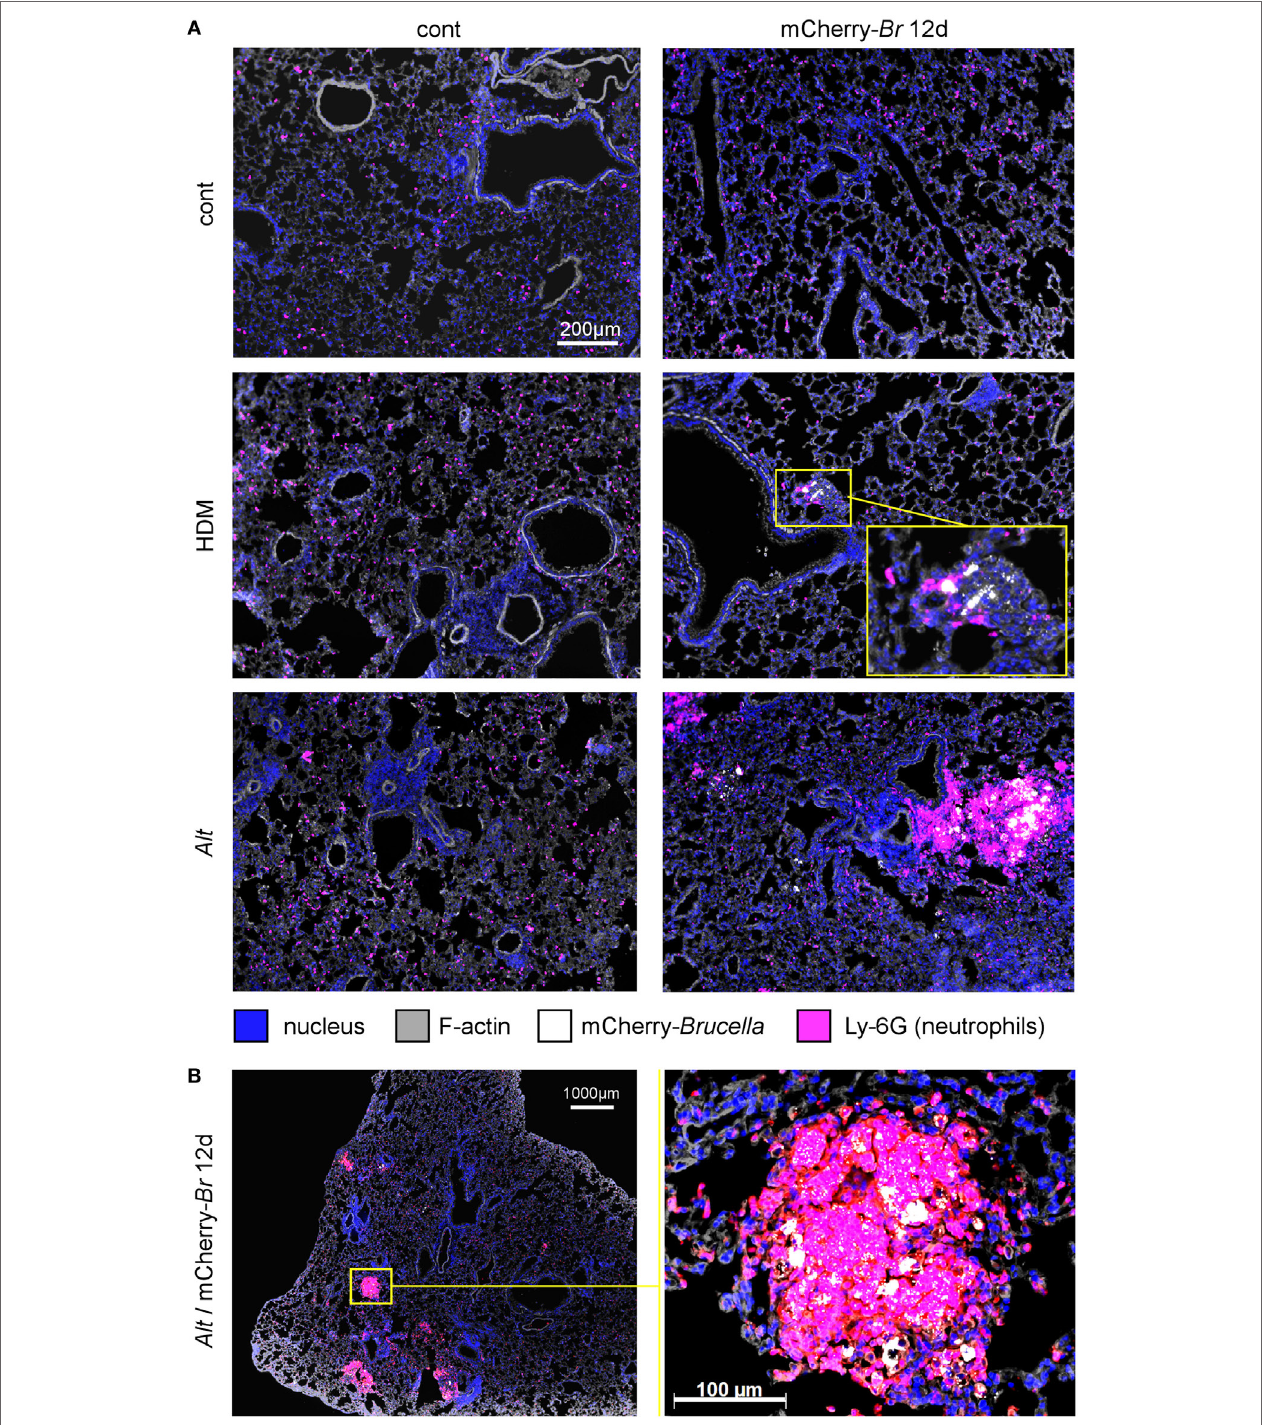
FigUre 2 | Microscopic analysis of lungs from control, HDM and Alt sensitized BALB/c mice. Wild-type BALB/c mice received repeated i.n. administration of phosphate-buffered saline (PBS) or Alt before i.n. inoculation of PBS or 2 × 10 4 CFU of mCherry- Brucella melitensis . The mice were sacrificed at 12 days post infection. The lungs were harvested and fixed. Frozen sections were examined by immunohistofluorescence for bacteria (mCherry signal) and Ly-6G-expressing cells. (a) Comparison of control (cont), HDM, and Alt sensitized mice, infected or not. (B) High magnification representative view from Alt sensitized infected mice. The panels are color-coded by Ag as indicated. The data are representative of two independent